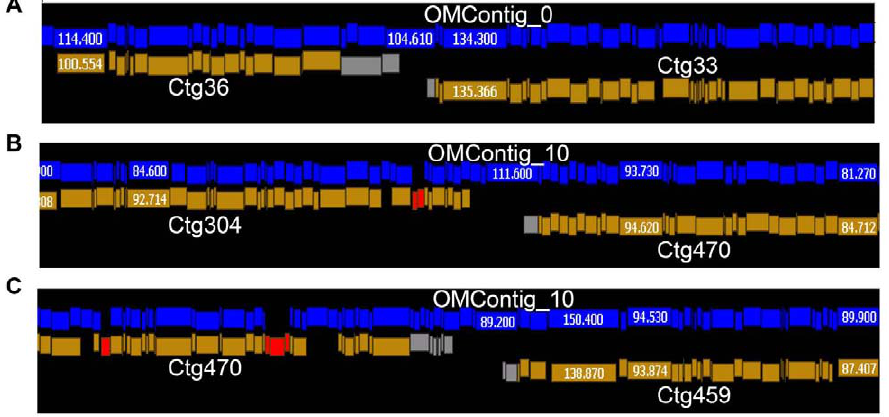
Figure 2. Use of the maize optical map for FPC contig anchoring. In each panel, the top blue fragments represent a maize optical Swa I restriction map, and the bottom orange fragments represent the in silico optical Swa I restriction map from contig-based pseudomolecules. Red fragments in (B) and (C) indicate a mis-sassmbly in the pseudomolecule that required manual editing. (A) Well-anchored Ctg36 helped to orient Ctg33, which was previously only ordered, but not oriented. (B) Anchored Ctg407 aided order and orientation of Ctg470, which was neither ordered nor oriented. (C). The newly anchored Ctg470 facilitated ordering and orienting of Ctg459.